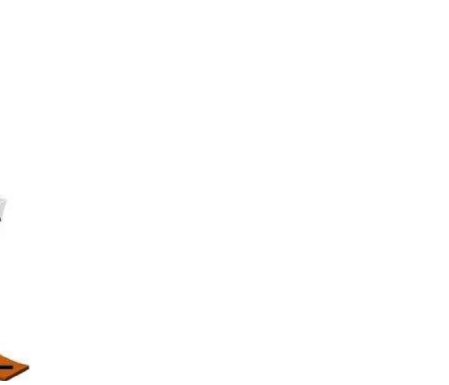
Figure 1. Internal structure of the nanogenerator device proposed in [58] based on the PVDF/ LiCl layer.